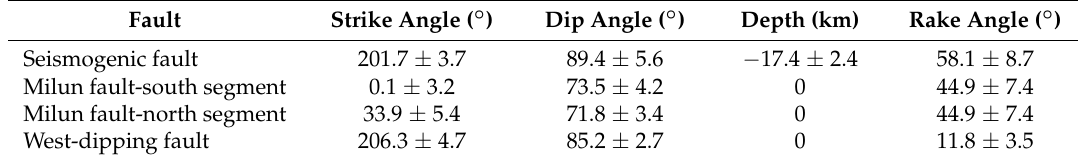
Table 2. Estimated fault parameters of the 2018 Hualien earthquake. Fault Strike Angle ( ◦ ) Dip Angle ( ◦ ) Depth (km) Rake Angle ( ◦